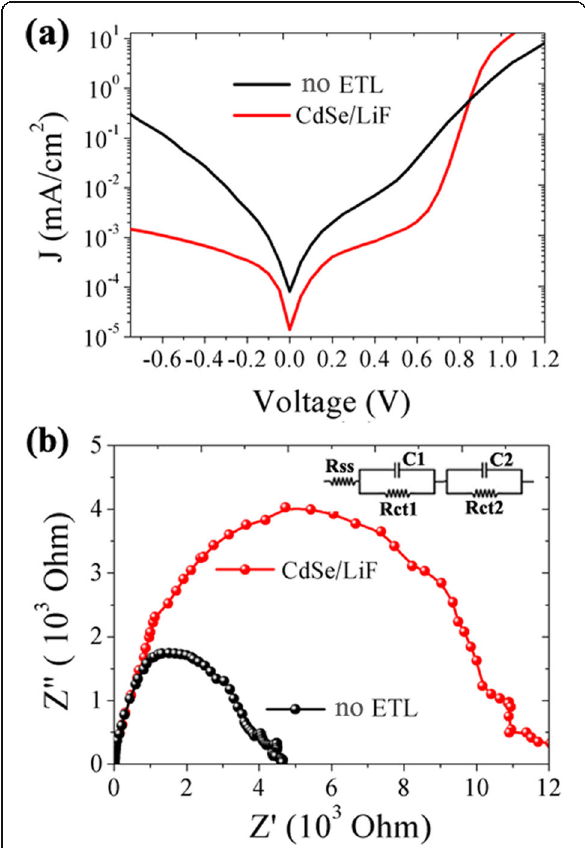
Fig. 6 Light intensity dependence of current density ( a ) and surface photovoltage spectrum ( b ) of the solar